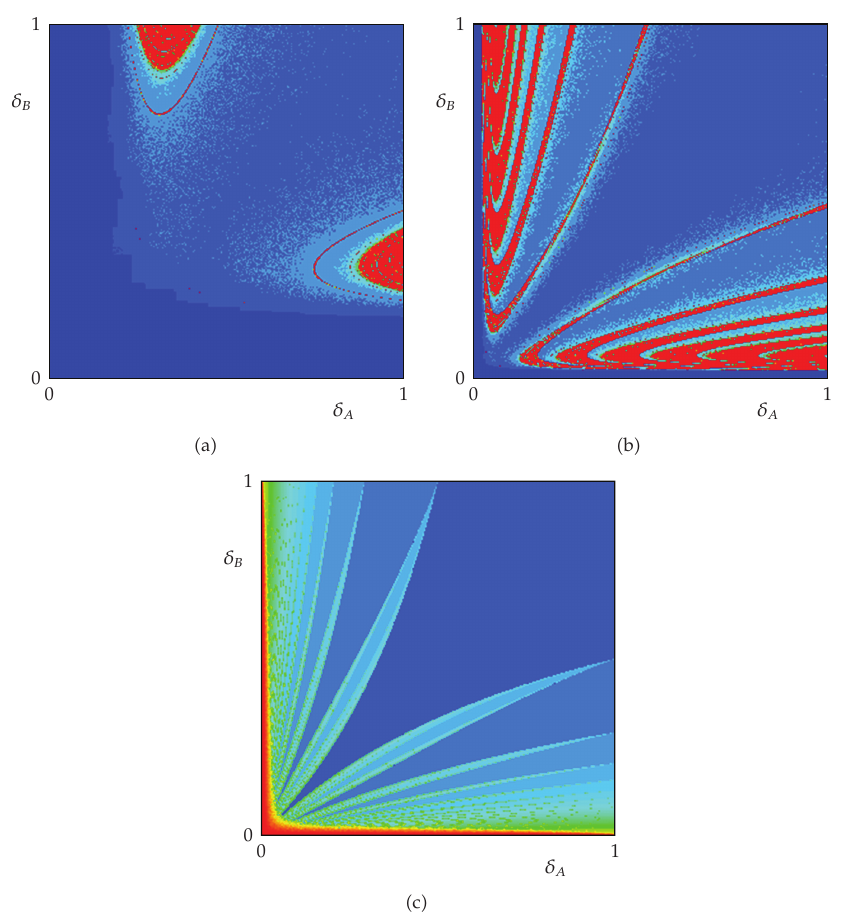
Figure 5: Bifurcation diagrams in the parameters’ plane (cid:2) δ A ,δ B (cid:3) , with (cid:2) a (cid:3) λ (cid:7) 20 (cid:2) b (cid:3) λ (cid:7) 60 (cid:2) c (cid:3) λ (cid:7) 500. Initial condition: x (cid:7) . 28; transient (cid:7) 4000, iterations (cid:7)